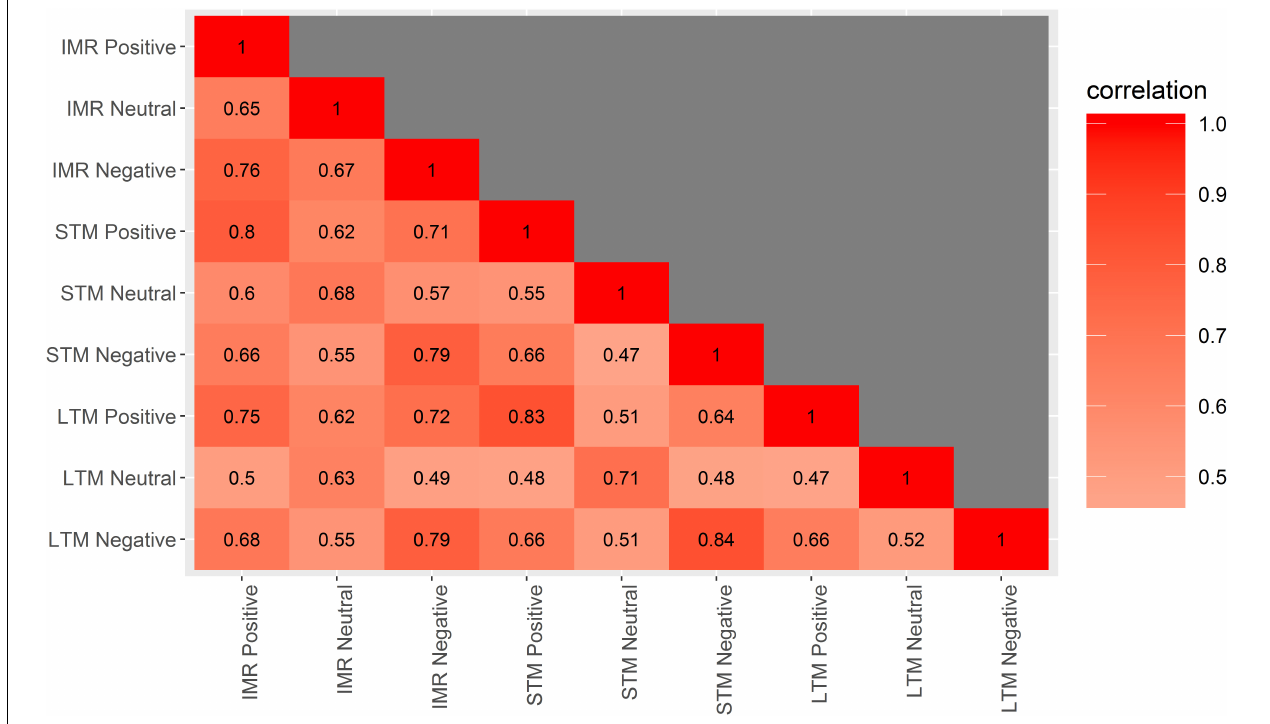
FIGURE 3 | Correlations between each valence for IMR, STM, and LTM VAMT-26 performances. Correlation matrix plot showing Pearson product-moment correlation coefficients between all valences (i.e., positive, negative, and neutral) within IMR (i.e., words recalled across IMR trials 1–5, i.e., IMR1 + IMR2 + IMR3 + IMR4 + IMR5), STM, and LTM. IMR, immediate recall; STM, short-term memory; LTM, long-term